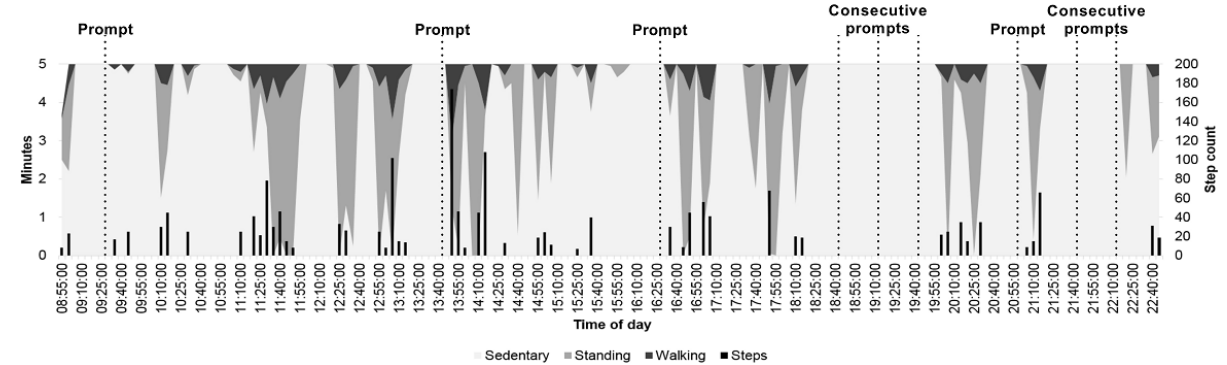
Figure 1. A concept diagram demonstrating where vibration prompts (set for 30 consecutive minutes sedentary) would occur during the course of a day. The dashed lines indicate where a vibration prompt would have occurred. The darker shaded areas depict where a patient has interrupted their sedentary time with standing and/or walking, and the black bars represent step count. Prompts at 9:30, 14:45, 16:30, 21:00 and 22:15 are followed by physical activity within 5 min of the prompt taking place. Prompts at 18:45, 19:15, 19:45 (3 consecutive prompts) and 21:45 are not followed by physical